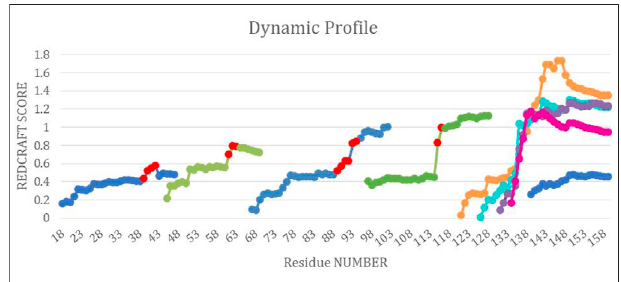
FIGURE 8 | The combined dynamic pro fi le for all REDCRAFT runs. The blue segments represent the dynamic pro fi le of the fi xed regions in DHFR, the greensegmentsrepresentthedynamicpro fi lefortherigidbodydynamicparts of DHFR, different runs for the uncorrelated dynamics fragment are represented in orange, cyan, purple and pink. Last, the red points indicate the start of increase in scores in the speci fi c dynamic pro fi le for that